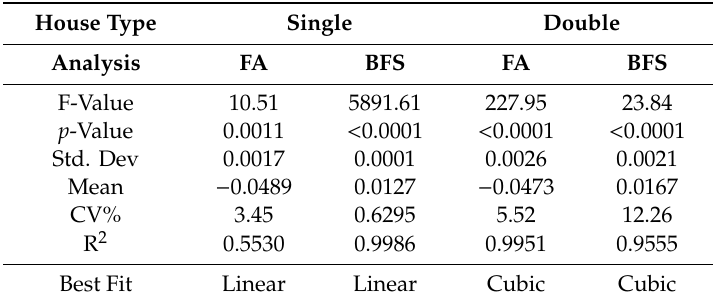
Table 3. Regression analysis